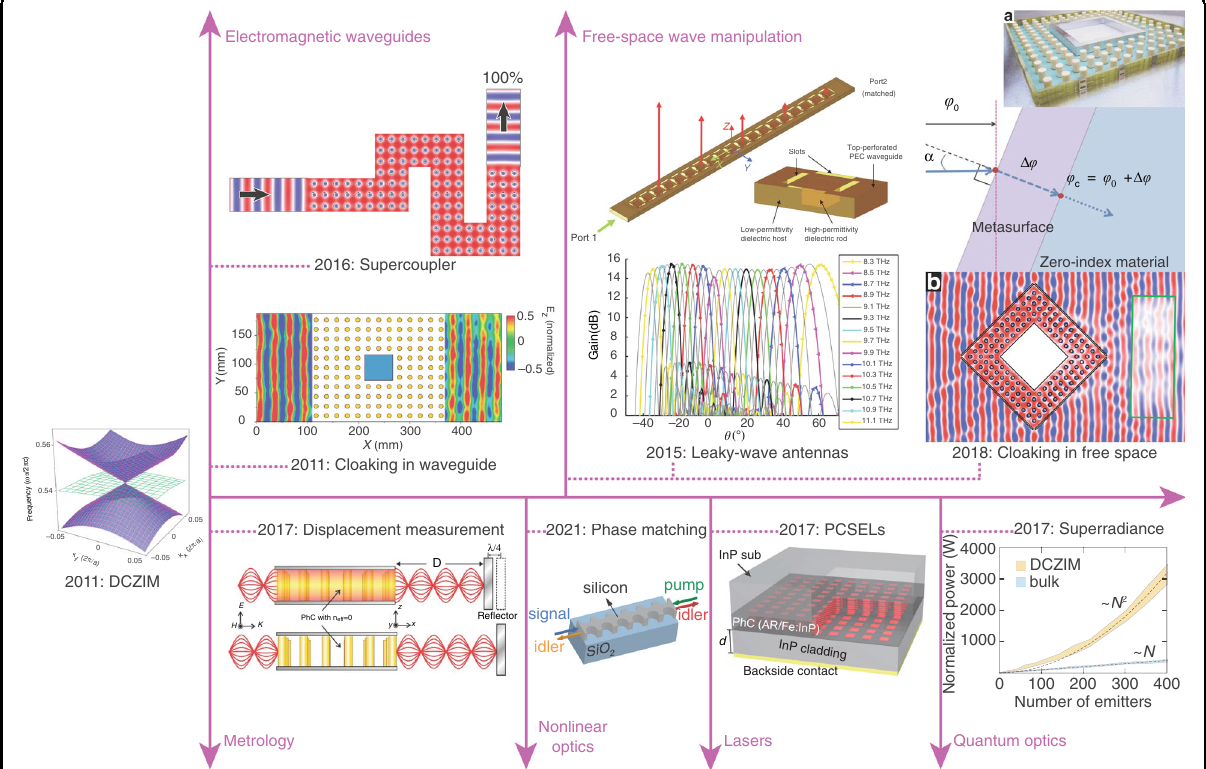
Fig. 6 Selected applications of DCZIMs in (from left to right, top to bottom) electromagnetic waveguides, free-space wave manipulation, metrology, nonlinear optics, lasers, and quantum optics. Supercoupler: simulated electric fi eld in a meandering waveguide fi lled with DCZIMs. Cloaking in waveguides: measured electric fi eld outside a DCZIM embedded with a metallic object. Leaky-wave antennas: schematic of the leaky- wave antenna based on a DCZIM (top) and the simulated gain at different operating frequencies (bottom). Cloaking in free space: the fabricated cloak consisting of a metasurface and a DCZIM with a central metallic rhombus as the hidden object (top); schematic shows that the metasurface changes the phase of incident wave from ϕ 0 to ϕ c (middle); the measured (inside green box) and simulated (outside green box) electric fi eld of the cloak area. Displacement measurement: schematic of the displacement measurement based on a DCZIM. Phase matching: Direction-independent phase matching of four-wave mixing in a DCZIM waveguide. PCSELs: a photonic-crystal surface-emitting laser (PCSEL) operating at a Dirac-point mode. Superradiance: simulated total power radiated from different-sized diamond DCZIMs embedded with randomly positioned dipole emitters. Figure adapted with permission from supercoupler 86 , PQDD; cloaking in waveguide 21 , Springer Nature Limited; leaky-wave antennas 88 , Springer Nature Limited; cloaking in free space 90 , Springer Nature Limited; displacement measurement 91 , © The Optical